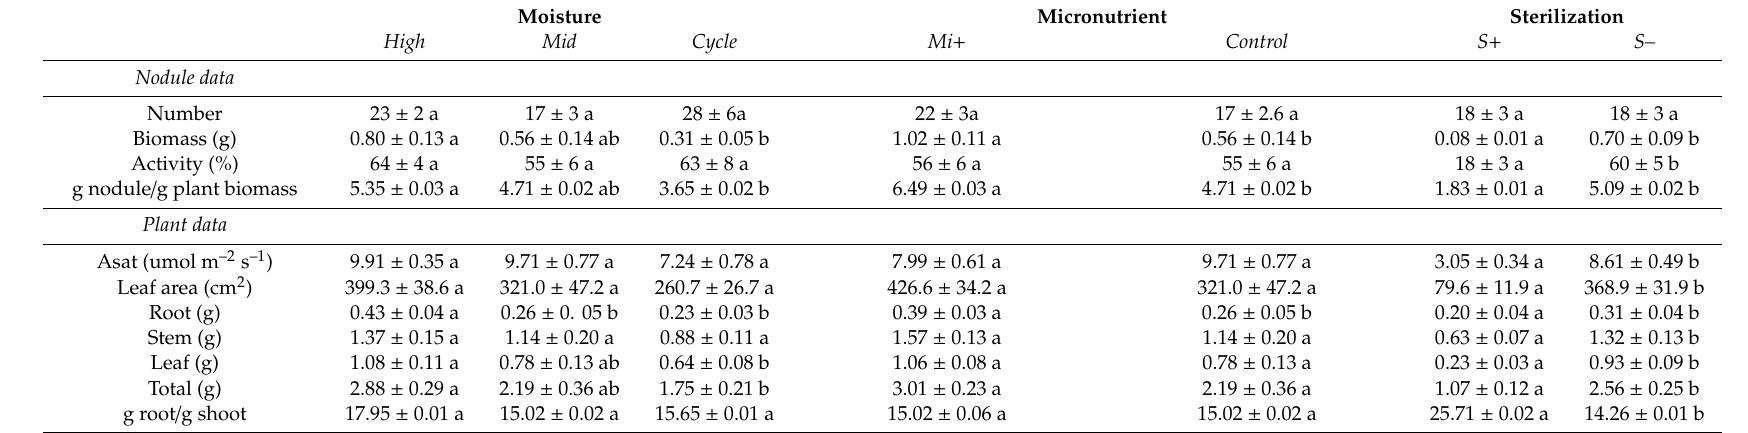
Table A2. Complete Results from Dominant Factor Assay. Values shown are means of 5 samples (3 in the case of Asat) +/ – 1